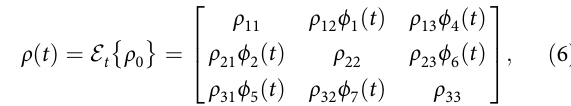
per se . Finally, we also note that the measure shares some similarities with the quanti fi cation of non-Markovianity 48 .